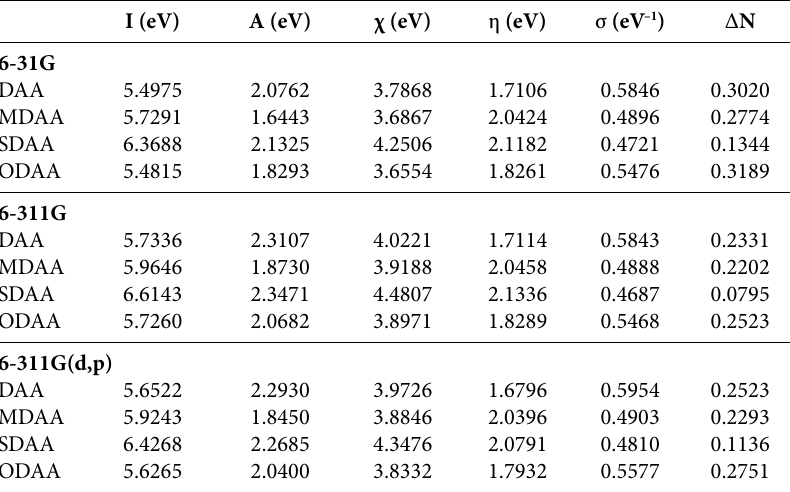
Table 2: Calculated quantum chemical descriptors for non-protonated molecules in gas